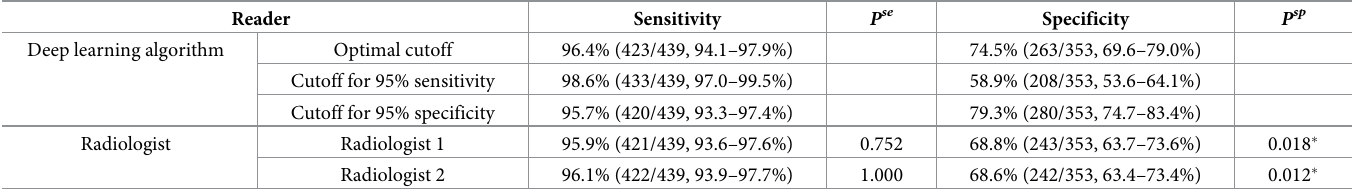
Table 3. Comparison of diagnostic performance for gold standard test set between the deep learning algorithm (using multiple views) and radiologists based on the labels by standard reference (temporal bone